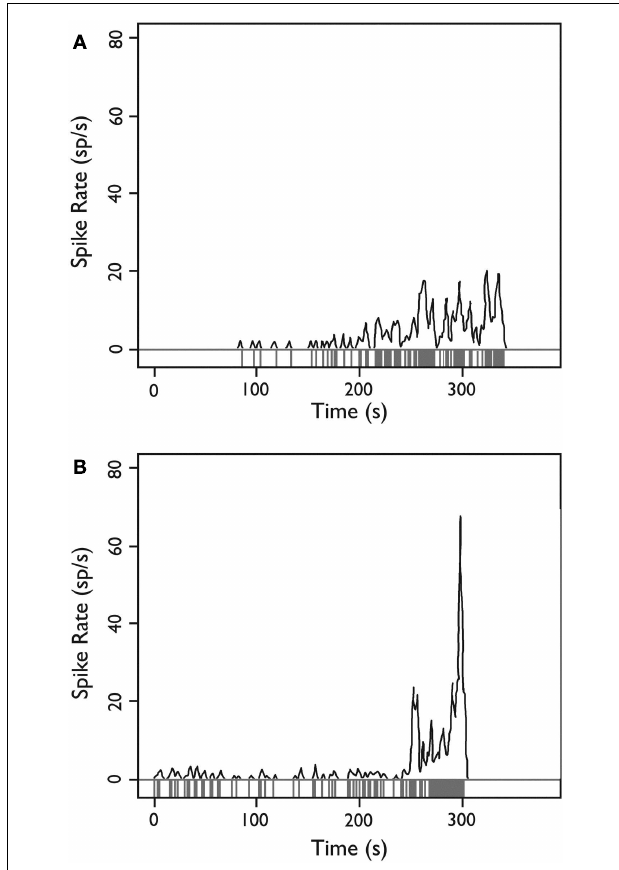
FIGURE 8 | Firing behavior over time for two HH neurons . (A,B) Each neuron demonstrates a sudden departure from baseline behavior with an evolving discharge of firing activity, potentially consistent with a local ictal discharge. Y -axis: firing rate in spikes per second estimated with a Gaussian kernel with SD = 1s; x -axis: time during recording epoch. Used with permission from Barrow Neurological Institute.